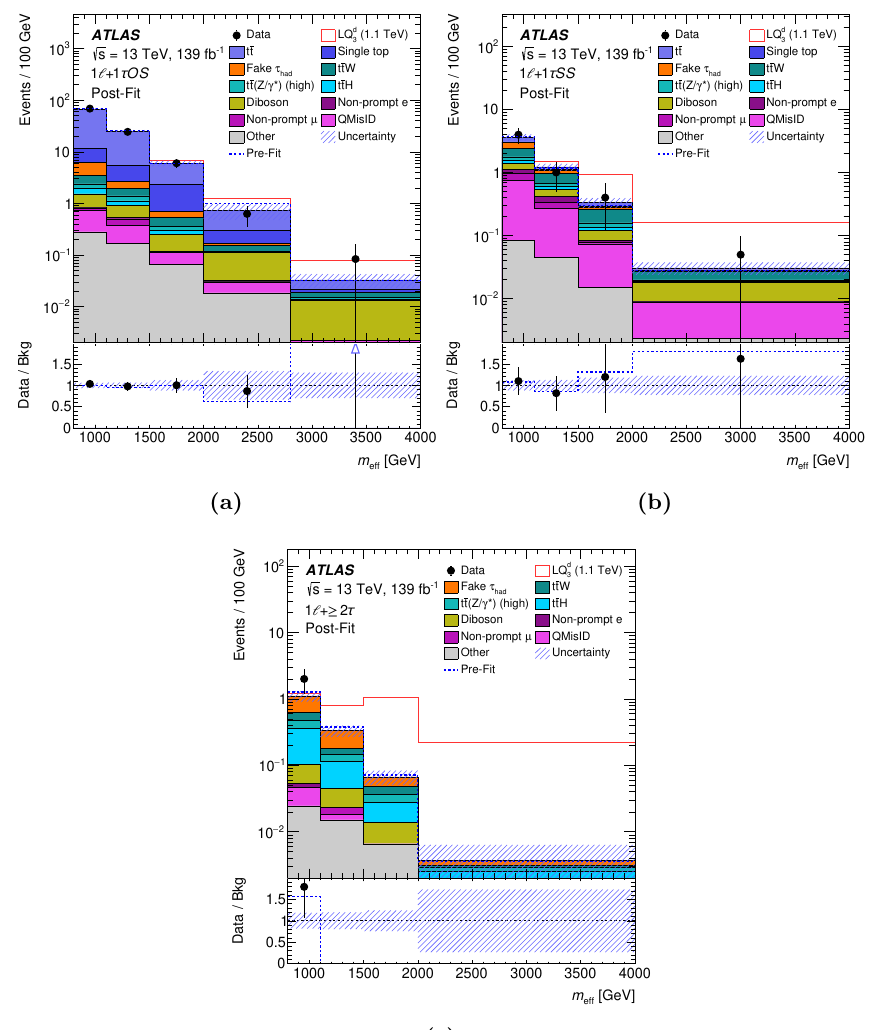
Figure 12. Comparison between data and prediction for the m eff distribution used in different signal region categories of the 1 ‘ + ≥ 1 τ channel: (a) 1 ‘ +1 τ OS, (b) 1 ‘ +1 τ SS, and (c) 1 ‘ + ≥ 2 τ . The background contributions after the likelihood fit to data (“Post-Fit”) under the background- only hypothesis are shown as filled histograms. For illustrative purposes, the expected signal for = 1 . 1 TeV and B = 1 is shown as a unfilled red histogram added to the post-fit background. m LQ d 3 The total background prediction before the likelihood fit to data (“Pre-Fit”) is shown as a dashed blue histogram in the upper panel. The ratio of the data to the background (“Bkg”) prediction is shown in the lower panel, separately for post-fit background (black points) and pre-fit background (dashed blue line). The size of the combined statistical and systematic uncertainty in the background prediction is indicated by the blue hatched band. The blue triangles indicate points that are outside the vertical range of the figure. The last bin in each figure contains the